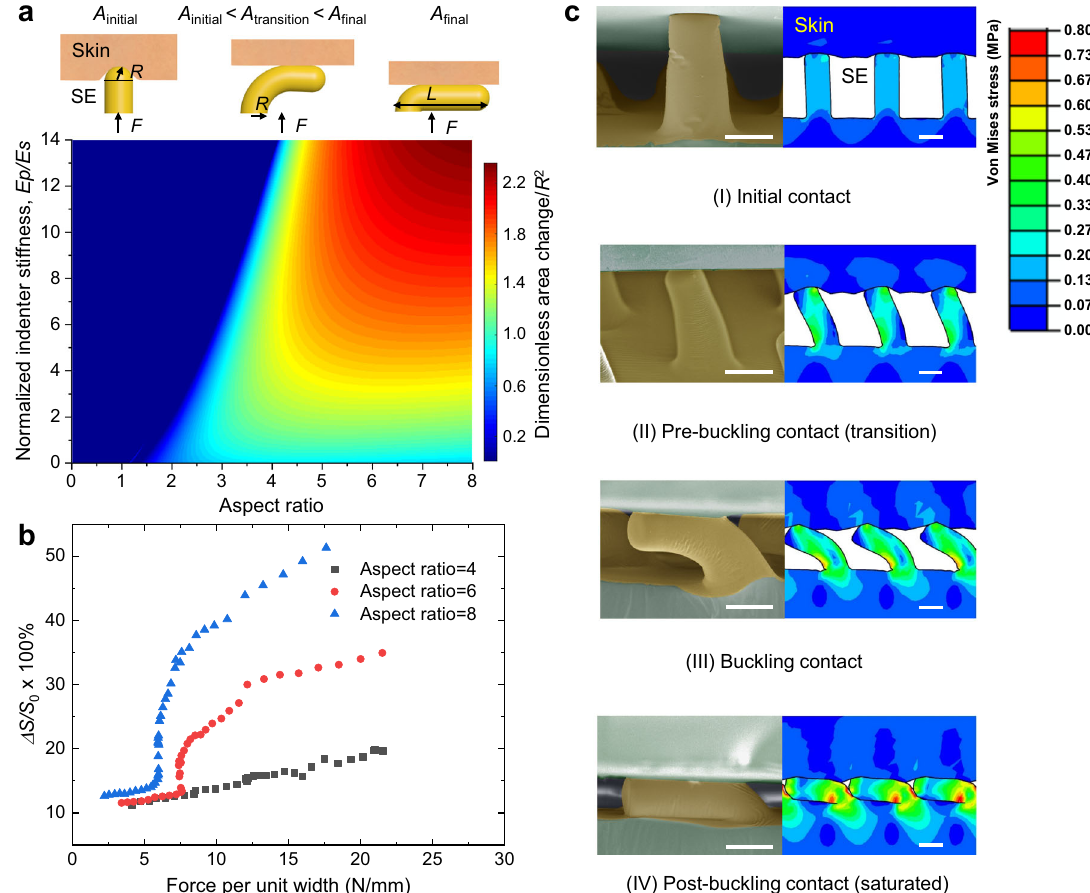
Fig. 2 Structural design considerations and numerical simulation of compressive deformation of the SEMS. a Schematics of elastic contact between a cylindrical pillar and a soft substrate before, during, and after the onset of buckling, here A initial , A transition , and A fi nal indicate the contact areas of initial contact, transition, and post-buckling, respectively. The difference of areas between initial and fi nal states normalized by the square of radius ( R 2 ) are calculated via Hertz Contact Models around the point of Euler buckling load, and plotted onto the color map, with two coordinates being the aspect ratio of cylinder and the ratio of indenter stiffness ( E p ) to that of the substrate ( E s ). Deep blue region indicates the indenter is over-stiff such that Euler buckling is not likely within a reasonable range of skin strengths. b Finite element simulations of relative area change ( Δ S normalized by the total available surface area S L / R ) of 4, 6, and 8. We assume plain strain condition with 33 pillars in a single 0 ) under monotonically increasing loads for three different aspect ratios ( unit. Boundary displacements are enforced via prescribing displacement and force feedbacks are averaged along the indenter ’ s fl at surface. c Visual comparison between experimental SEM images and FEA simulation results. The morphologies of deformed pillars throughout buckling show good consistency with experimental observations. Color indicates von Mises stress amplitudes. This experiment is repeated independently for at least three times (SE: sensing electrode). All scale bars are 10